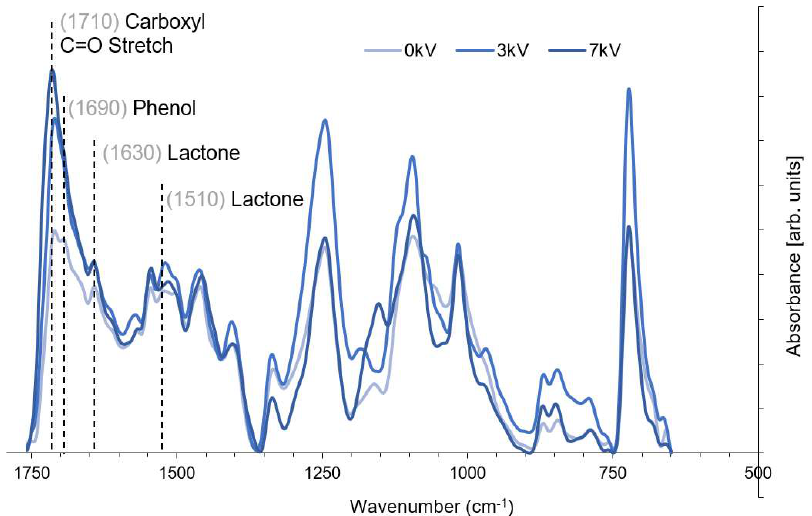
Figure 9. Fourier Transform Infrared Spectrometry (FTIR) spectra of the ACC samples, under different applied potentials (0 kV, 3 kV, and 7 kV).